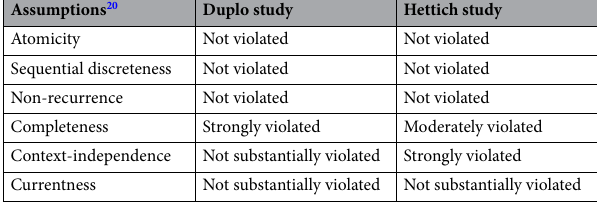
Table 1. Degrees of violation of SDA-M algorithms’ assumptions in assembly